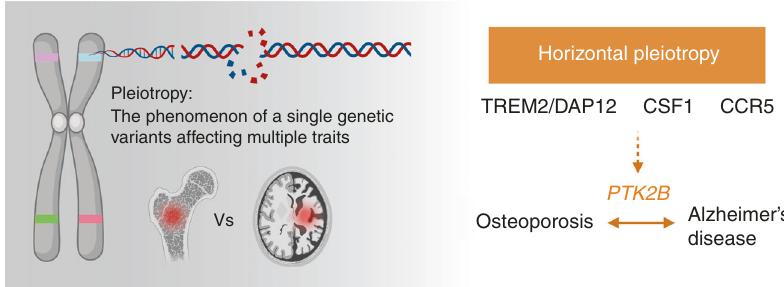
Fig. 3 Horizontal pleiotropy of common genetic factors. Pyk2 signal could be a converging pathway of the genetic correlation between osteoporosis and Alzheimer ’ s disease (AD). Genetic variants in PTK2B are signi fi cantly associated with AD, body mass index, and bone mineral density suggesting that the two traits — osteoporosis and AD — could be linked by horizontal